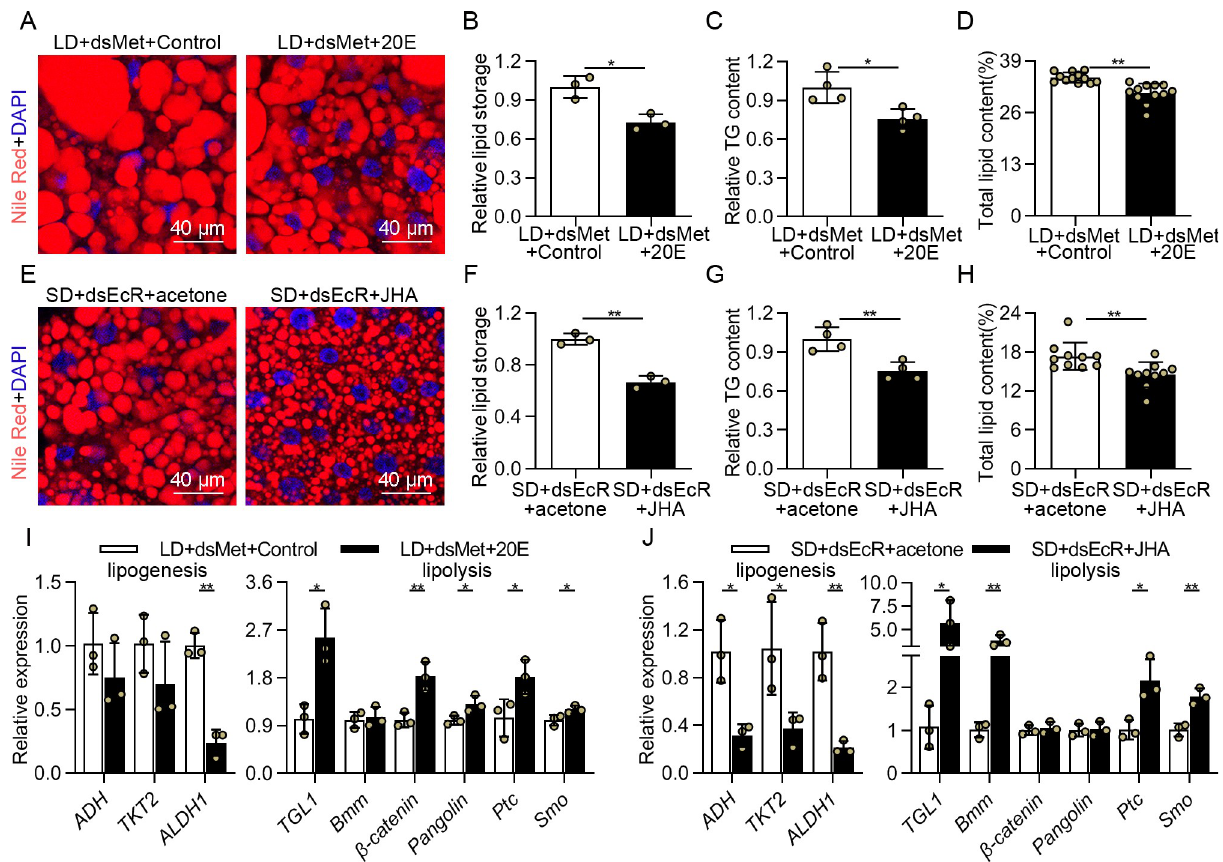
Fig 7. The regulation of lipid accumulation by 20E and JH signaling pathways under photoperiodic conditions. (A) Nile red staining was performed in the fat bodies of the LD-induced female adults after dual-injection with dsMet and 20E. (B) Relative intensity of fluorescence of lipid droplets quantitatively analyzed by using ImageJ. Meanwhile, (C) the relative TG content and (D) total lipid content were detected in the whole body at 4 days PE. (E) At 0 days PE, the reproductive females were microinjected with dsEcR following a 24 h induction with 30 μ g of JHA to study the lipid accumulation in the fat body at 4 days PE using Nile red staining. (F) Relative intensity of fluorescence of lipid droplets quantitatively analyzed by using ImageJ. Statistical analysis for (G) relative TG content and (H) total lipid content after dual-injection with dsEcR and JHA. Relative levels of key genes related to lipolysis and lipogenesis transcripts in the fat bodies after (I) dual-injection with dsMet and 20E, as well as (J) dsEcR and JHA. Relative gene expression values in the treatment group are presented as fold changes compared to the control groups. Error bars represent the sd. � P < 0.05, �� P <